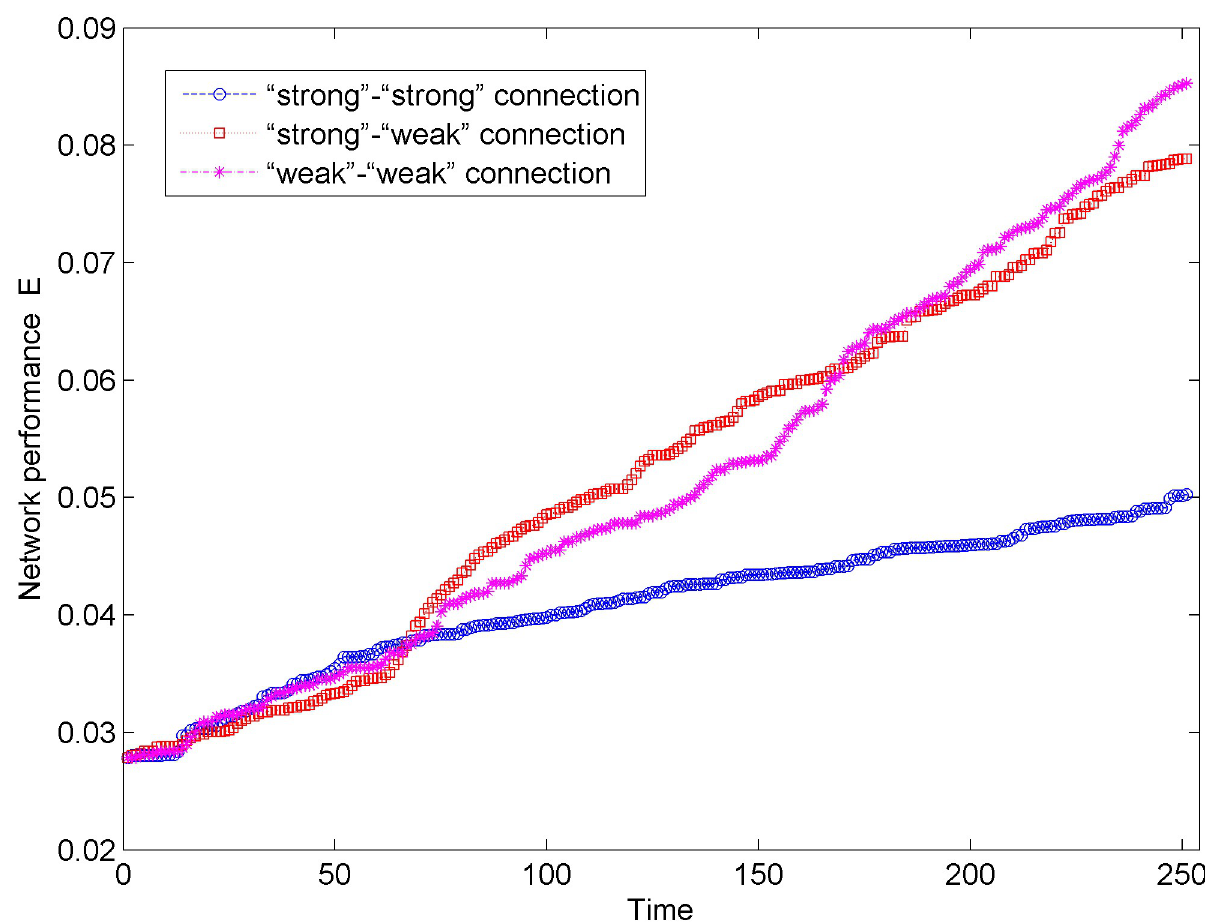
Fig 7. Changes of network performance in the unweighted